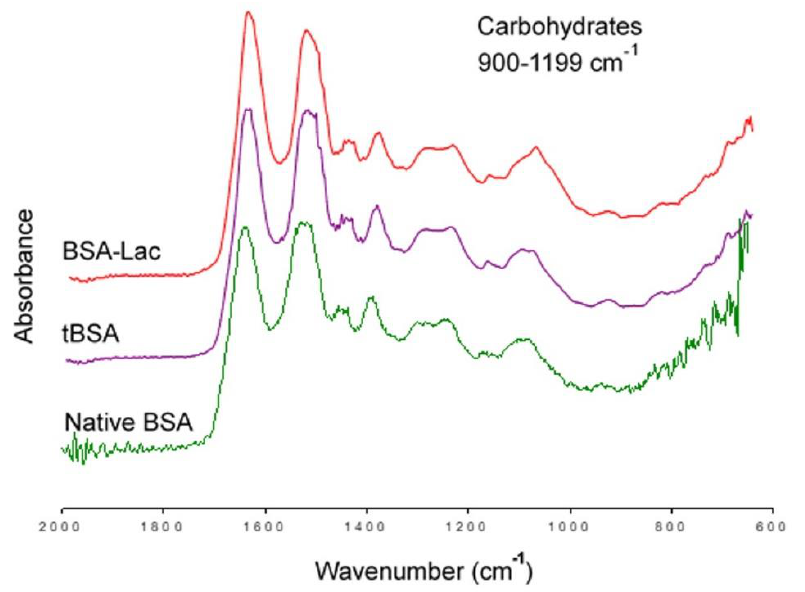
Figure 3. Fourier transform infrared spectroscopy (FT-IR) of BSA-Lac (red), tBSA (purple), and native BSA (green).